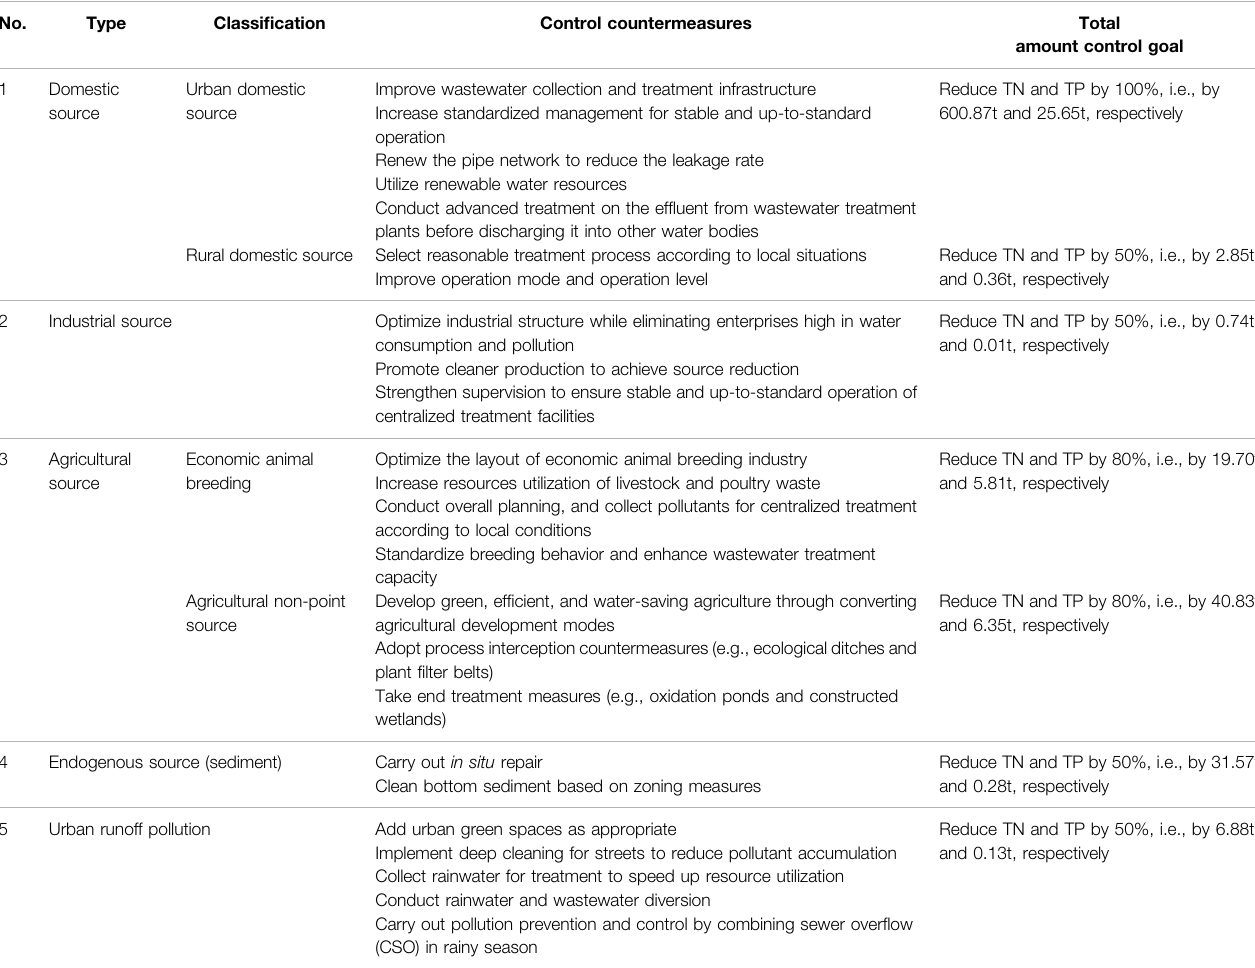
TABLE 7 | Control countermeasures for pollution sources in the Zhangze Reservoir.